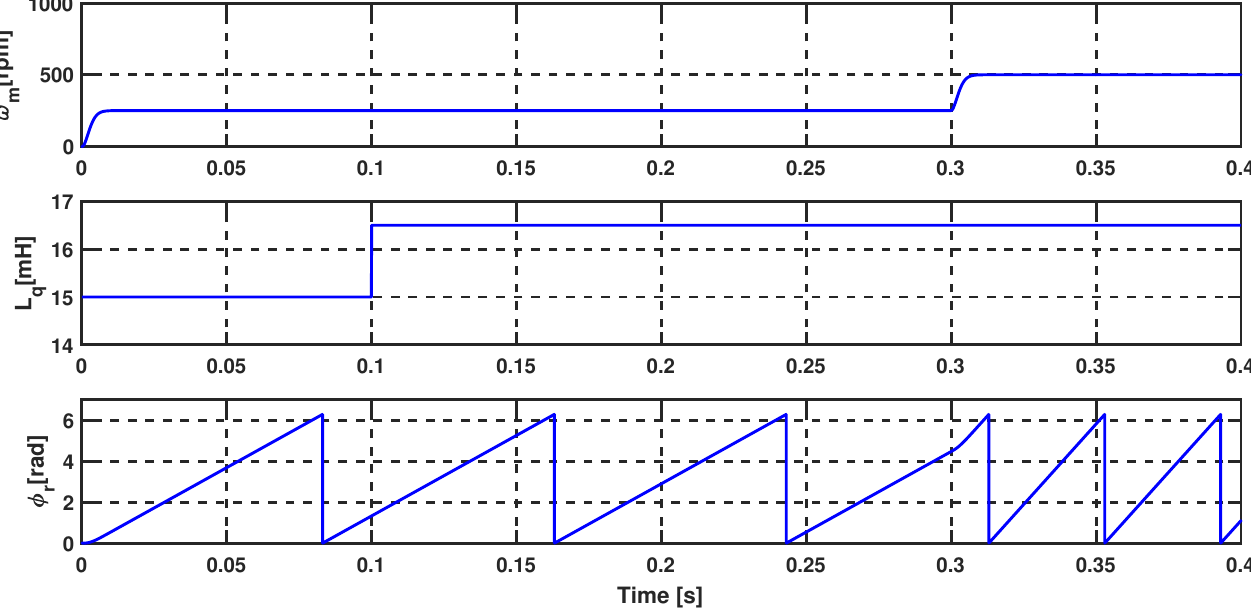
Figure 15. Simulation results of multiple vector 3VV FCS-MPC at step change in the PMSM inductance L q (from top): Speed ω m , inductance L q , and rotor angle φ r